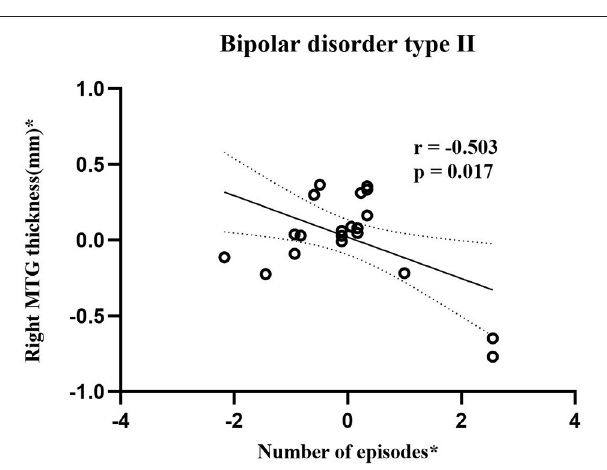
FIGURE 2 | Scatterplots show correlation between cortical thickness in right MTG and number of episodes in adolescent bipolar disorder type II subjects. Asterisk (*) represents the residuals removing the effect of age and gender. The horizontal and vertical axes represent residuals of number of episodes and right MTG thickness, respectively. Bipolar disorder type II group showed significantly negative correlations ( r = − 0.503, p = 0.017, Power = 0.695) between cortical thickness in right MTG and number of episodes. MTG stands for middle temporal gyrus.